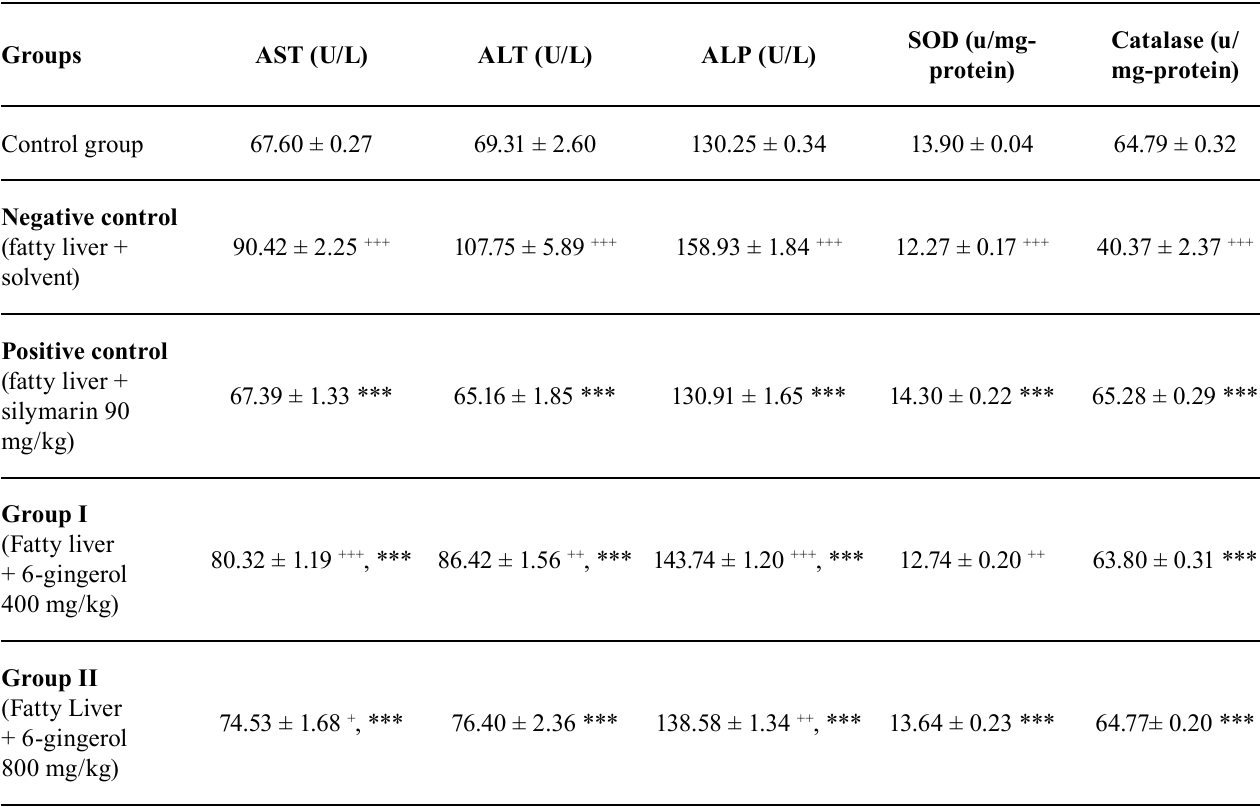
TABLE III – Levels of hepatic and antioxidant enzymes in mice receiving control diet, high-fat diet, and 6-gingerol. n = 6/group